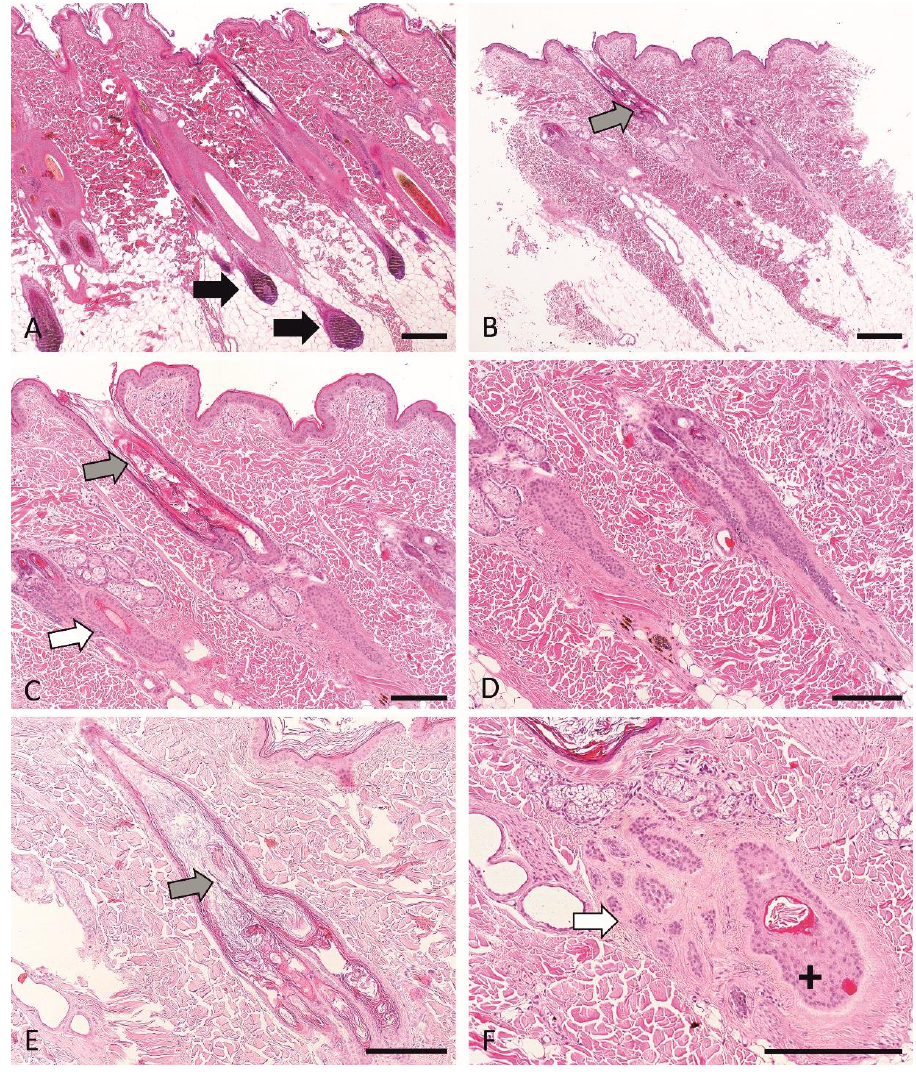
Figure 3. Histological representation of biopsy samples from control skin from unaffected dogs ( A ) and affected dogs (B – F ). Note numerous anagen hair follicles in A identified by the presence of numerous hair bulbs (black arrows). In aRFA, infundibuli (gray arrows) are moderately to se- verely dilated ( B , C , E ) and are filled with abundant keratin, which extends into the openings of the secondary follicles, resulting in a “witch’s feet”-like appearance ( E ). The follicular parts proximal to the infundibuli are shortened and limited to the dermis ( B – E ). A few telogen follicles ( C , white arrow) or kenogen follicles ( F , white arrow) can be identified. Follicular atrophy may be seen (F, black cross). A mild distortion of the HFs is observed ( B – F ). All samples are stained with hematox- ylin and eosin (H&E) and the scale bars represent 200 microns. 3.7. RNA Sequencing Analysis Single-end sequencing of the fifteen RNA libraries produced a mean number of 37,377,469 million (M) reads per sample on average (range: 31,686,907–43,209,034 M). The mean percentage of reads uniquely mapped to the genome was 90.19%, ranging from 87.50–91.59%. Among those, 80.84% on average mapped to the annotated canine tran- scriptome (range: 75.65–86.25%), resulting in 26 M counts per sample on average.